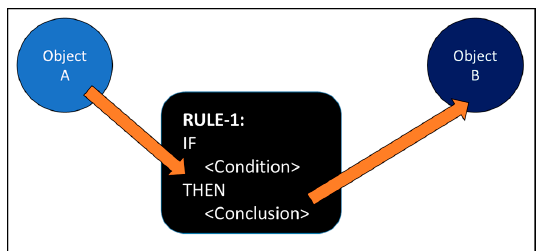
Figure 6. Drools Pattern Matching Mechanism.